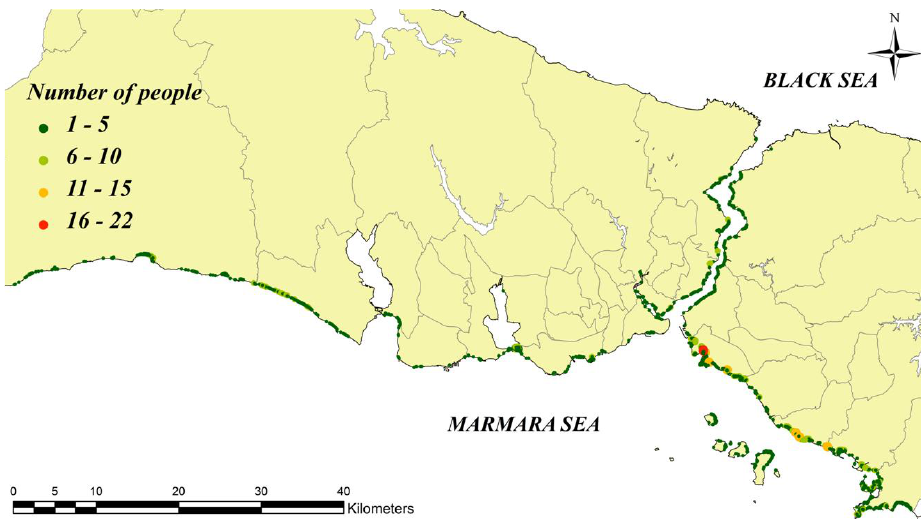
Figure 6. Spatial distribution of the number of people residing in the exposed buildings.